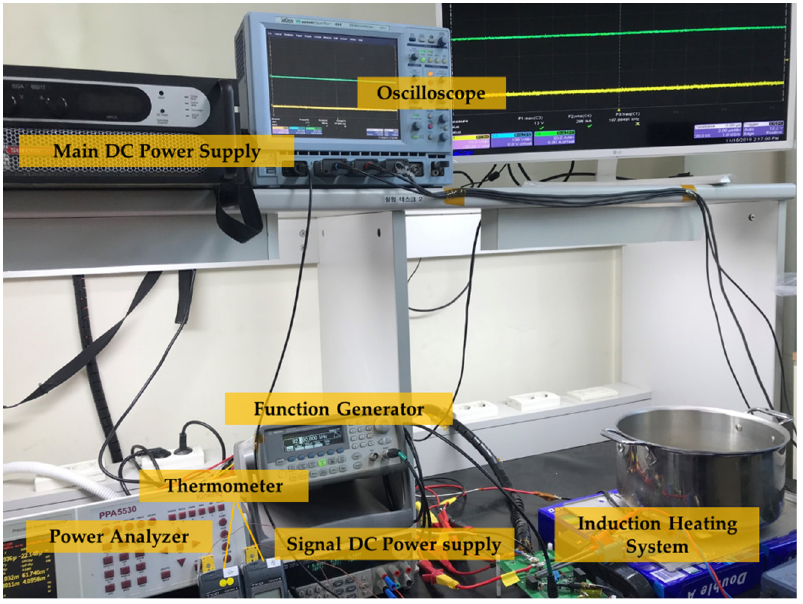
Figure 8. IH system experiment configuration.